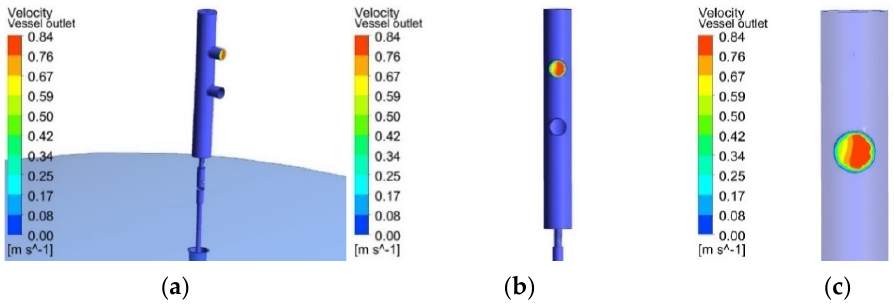
Figure 9. Velocity outlet, high-pressure section: ( a ) Isometric view, ( b ) Front view, ( c ) location velocity outlet (zoom).